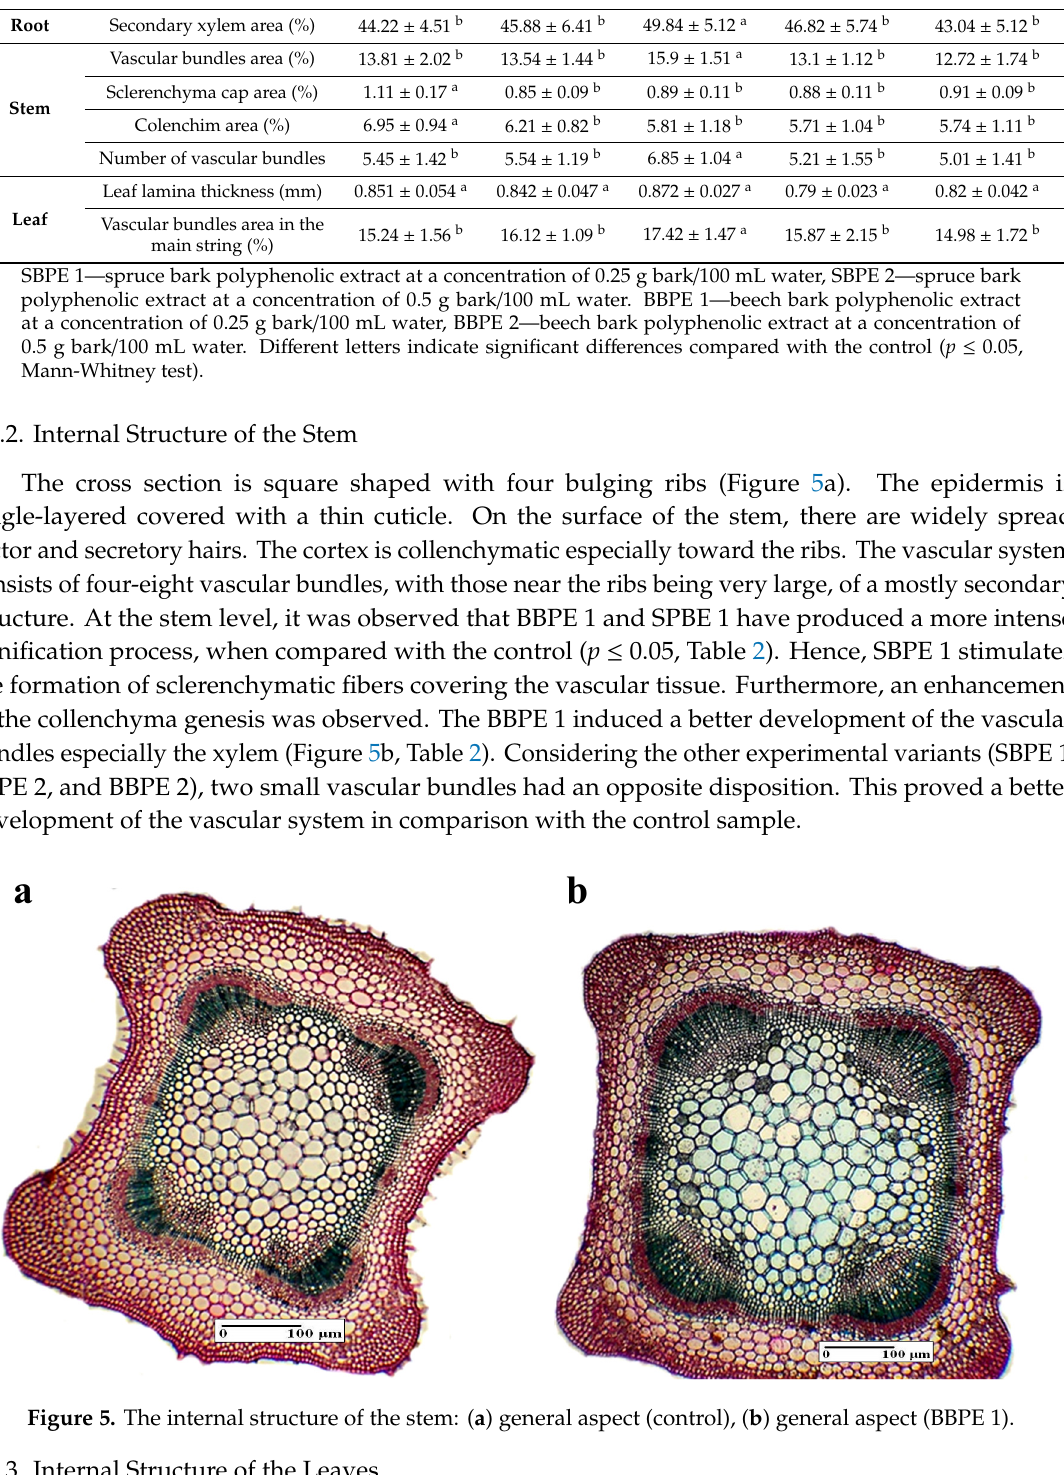
Table 2. The microscopic characteristics of vegetative organs in case of treated and control lemon balm plants.